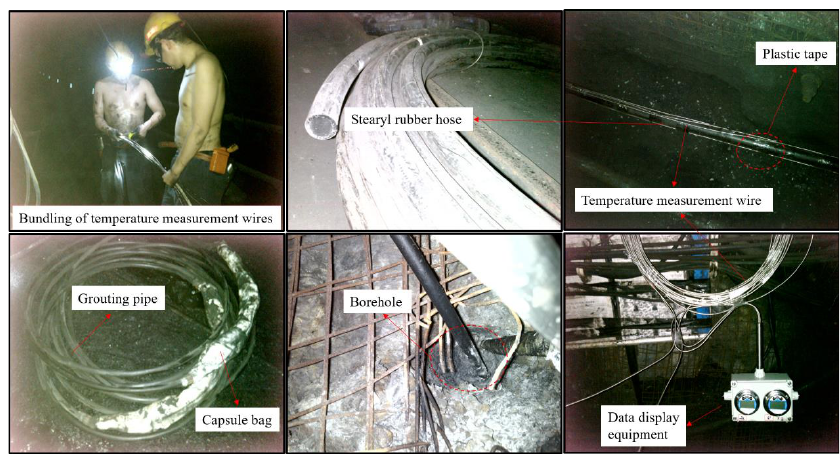
Figure 3. Pre-embedded temperature sensor process.